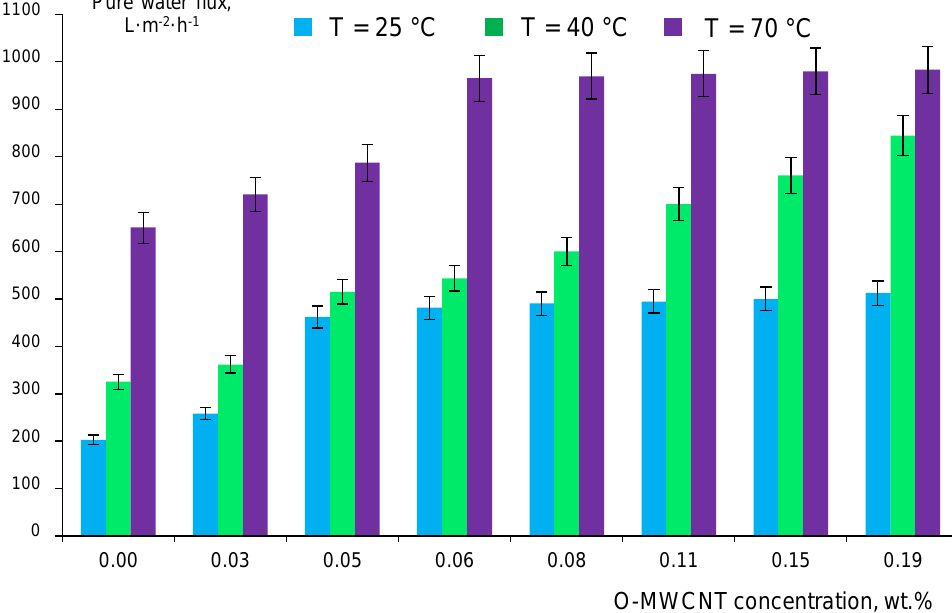
Figure 10. Pure water flux versus O-MWCNTs concentration in the casting solution, coagulation bath temperature: blue color—T cb = 25 °C; green color—T cb = 40 °C and violet color—T cb = 70 °C.